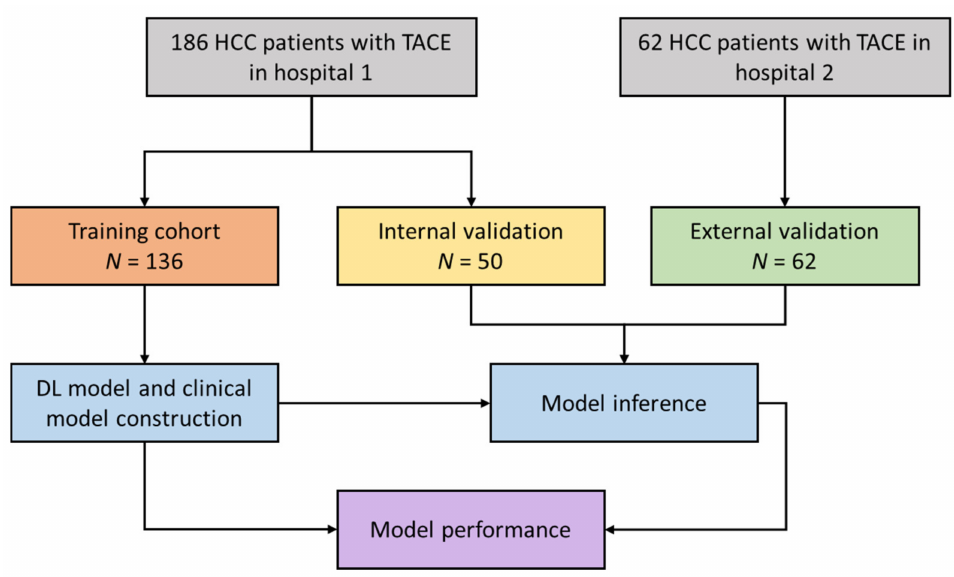
Figure 1. The diagram of the patient inclusion, model construction, and performance